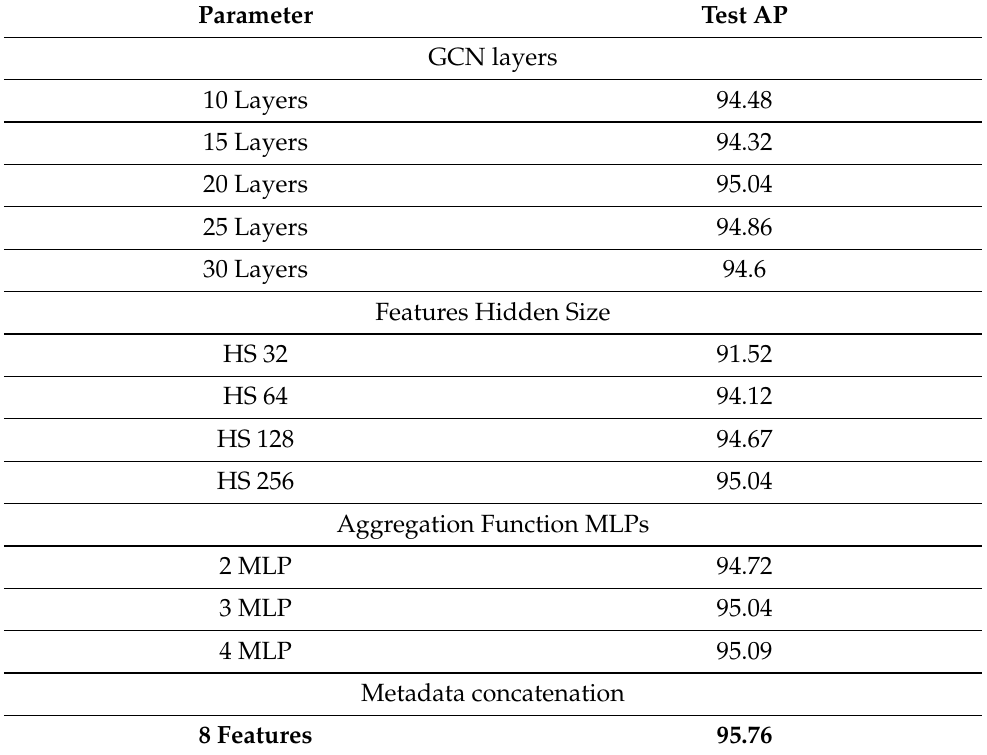
Table 5. Binary AMPs-Net performance. Optimization of the GCN Module. In bold best configura- tion